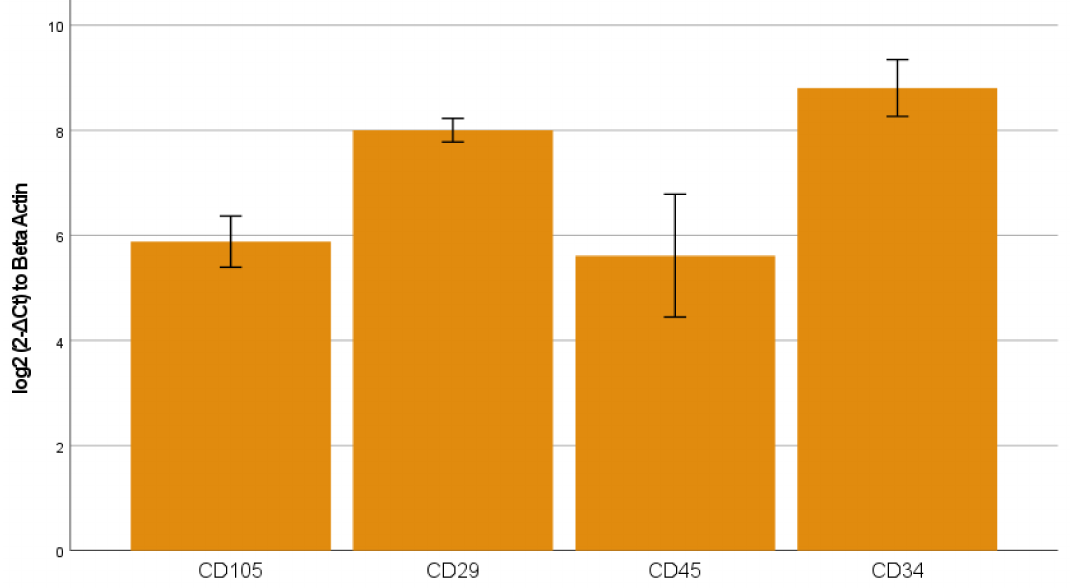
Figure 2. mRNA expression of genes involved in mesenchymal and haematopoietic lineages was determined by qPCR. Transcript levels were normalized to the ACTB reference gene using log2 (2- ∆ Ct) method. The data is presented as mean ± standard error (SE). The graph bar shows expression level of the genes CD105, CD29, CD45, and